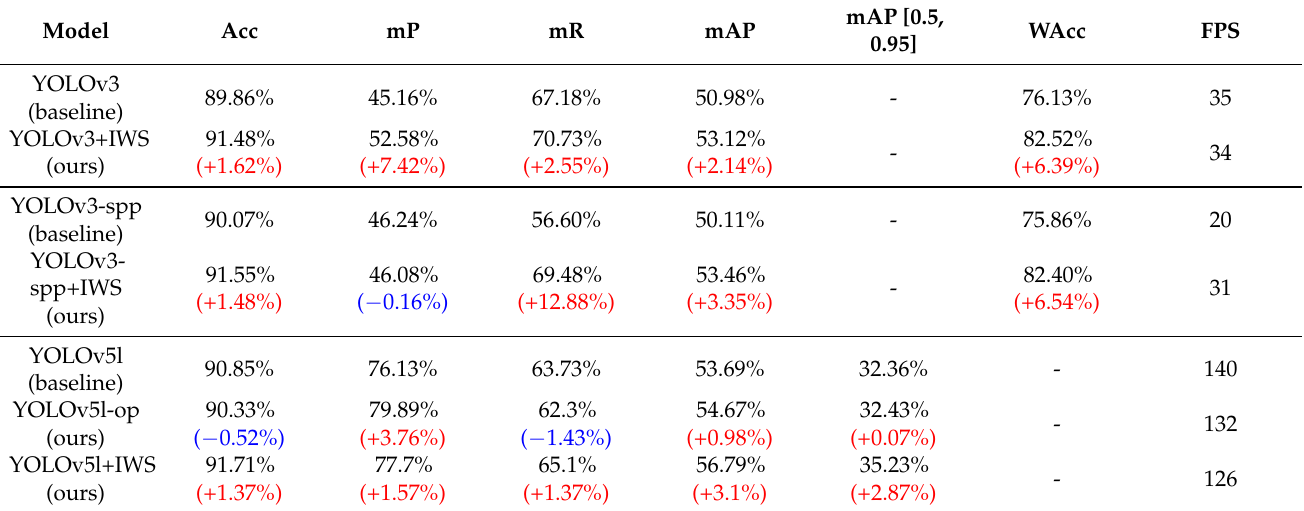
Table 7. Experimental results (more experimental results can be found in Table A1) of the IGBT_DF dataset based on YOLO series.